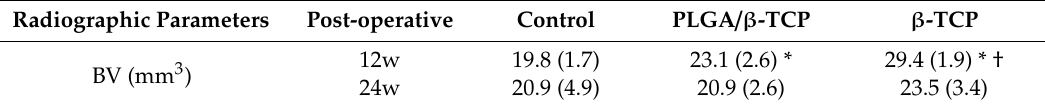
Table 2. CT measurement of bone volume between 12 weeks and 24 weeks